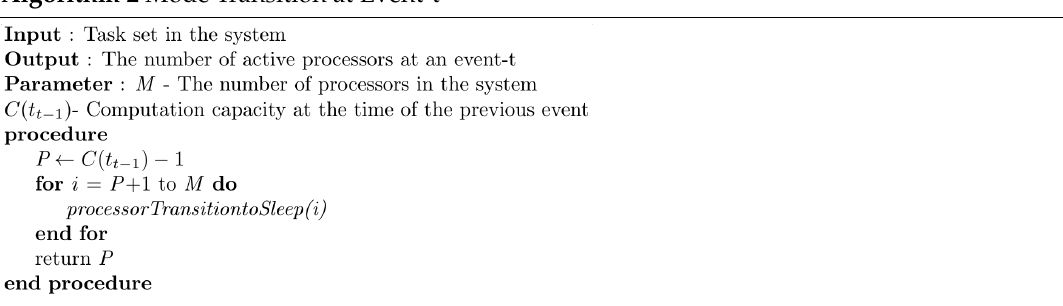
Algorithm 2 Mode Transition at Event-t